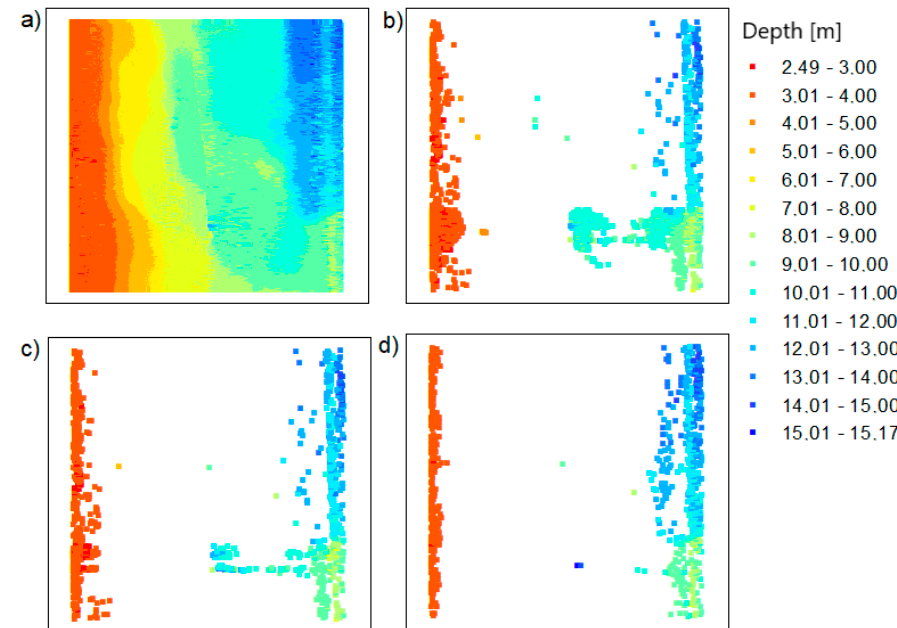
Figure 6. The points based on the LNG port area: ( a ) raw data; ( b ) dataset reduced with the Optimum Dataset (OptD) method for setting no. 1; ( c ) dataset reduced with the OptD method for setting no. 2; ( d ) dataset reduced with the OptD method for setting no.